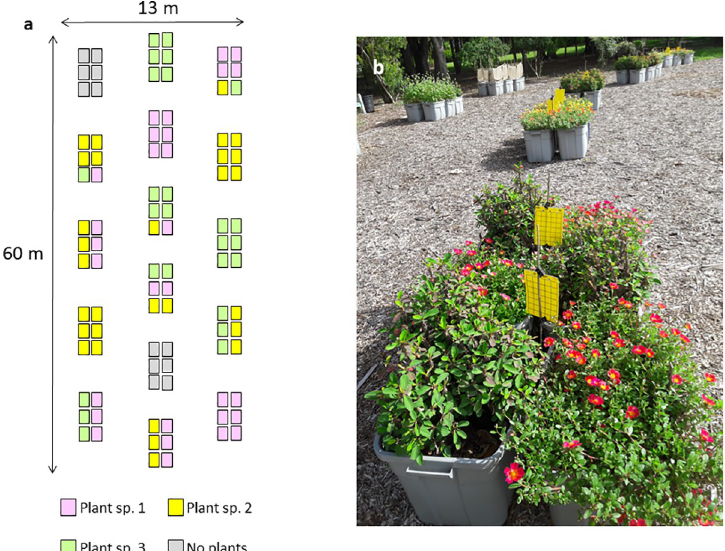
Fig 2. a) Diagrammatic representation of test array showing arrangement of planter boxes in each test mixture group. Each planter box contained only a single plant species and the number of planter boxes between mixture groups was kept constant. Colors indicate placement of each plant species within each mixture group to generate proportionalities. Arrows indicate dimensions of the study site. Not to scale. b) Photograph of the Summer 2018 Experiment showing a section of the study site and mixture treatment groups. The treatment group in the foreground is the 1:1 mixture of Portulaca umbraticola and Euphorbia milii .